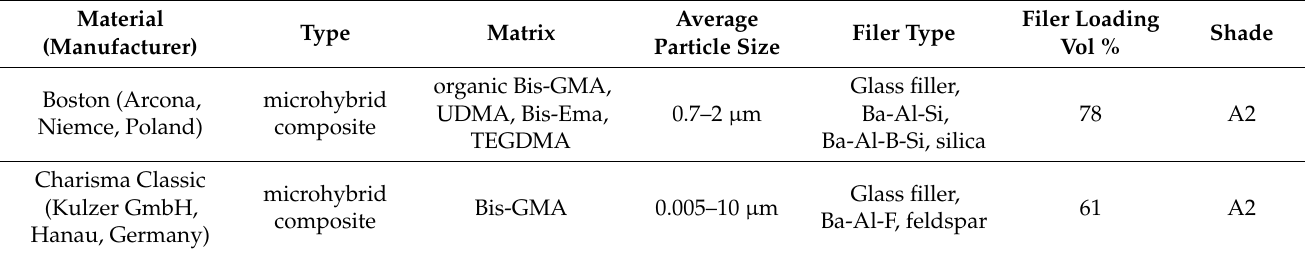
Table 1. Characteristics of Composite Materials Used in the Study.